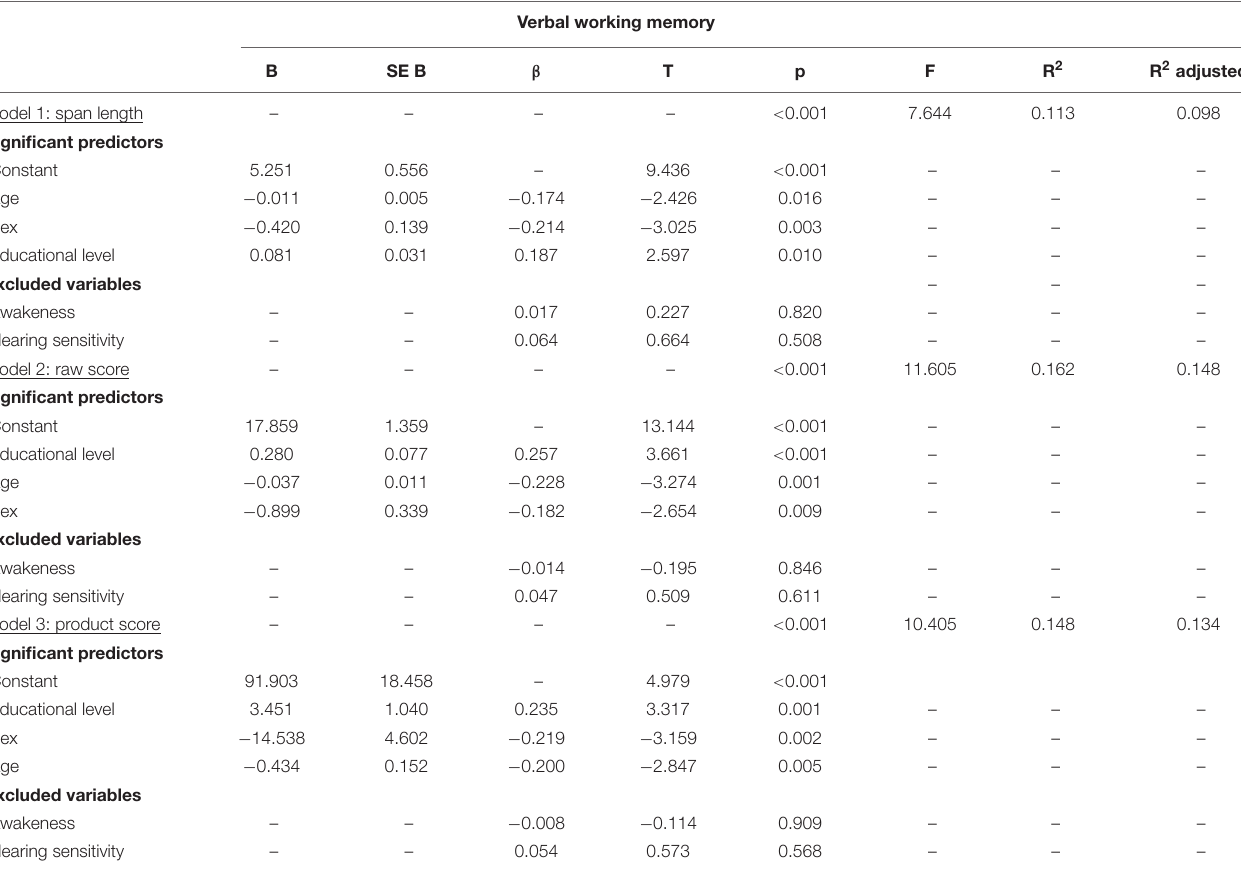
TABLE 5 | Stepwise multiple regression with age, sex, educational level, awakeness, and hearing sensitivity as independent variables and verbal working memory (span length, raw score, and product score) as dependent